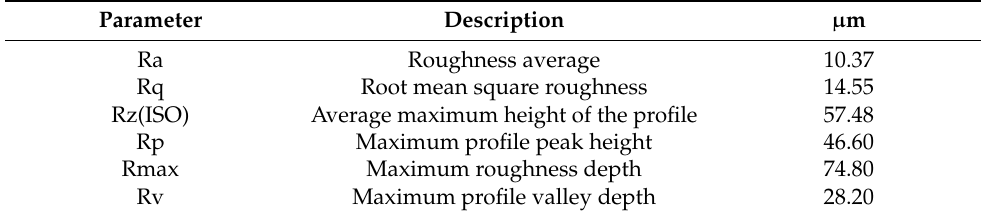
Table 1. Transitions selected for